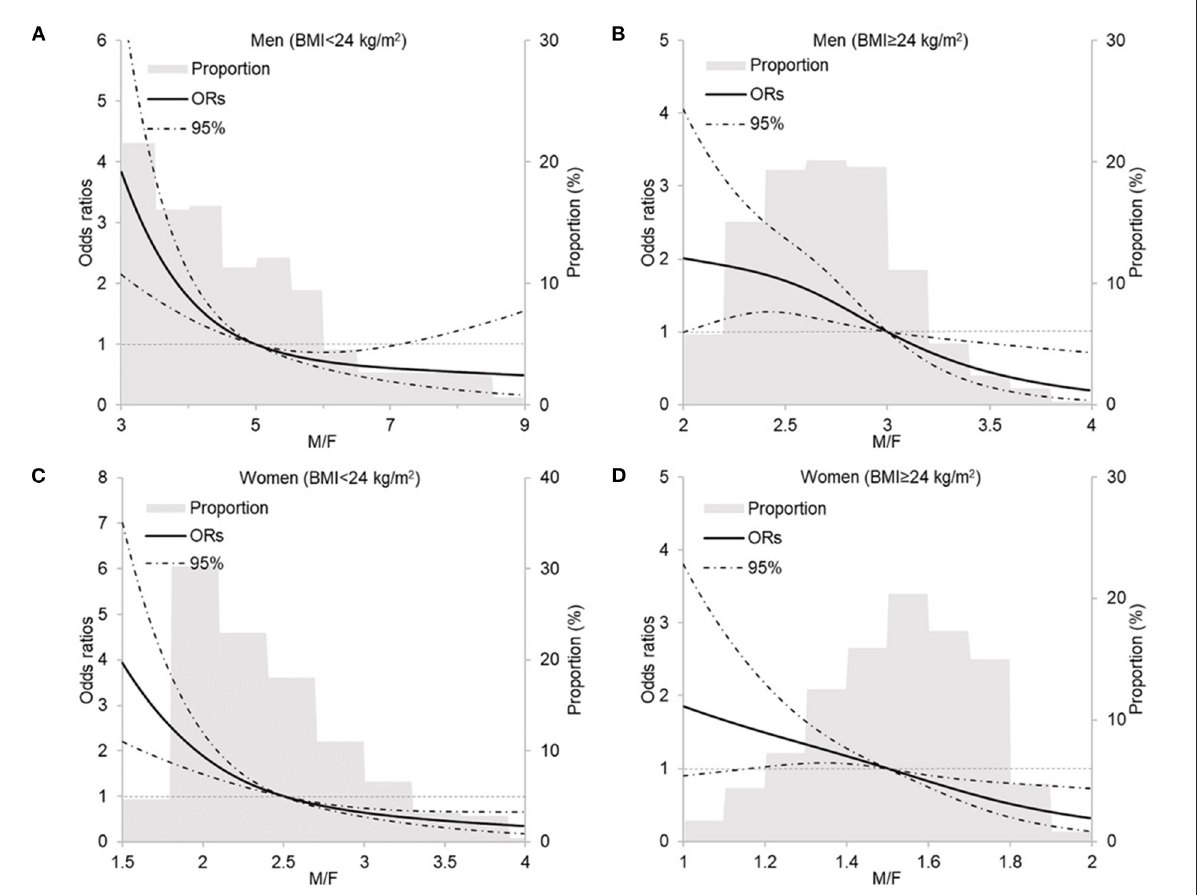
FIGURE2 Restricted cubic spline analysis of the relationship between M/F with metabolically unhealthy phenotype by sex and BMI. (A) men, BMI < 24 kg/m 2 , P linear < 0.0001; (B) men, BMI ≥ 24 kg/m 2 , P linear = 0.7122; (C) women, BMI < 24 kg/m 2 , P linear < 0.0001; (D) women, BMI ≥ 24 kg/m 2 , P linear = 0.2234. M/F, muscle-to-fat ratio; BMI, body mass index. Models included age, residence, education, income, smoking status, drinking status, occupational physical activity, and leisure-time